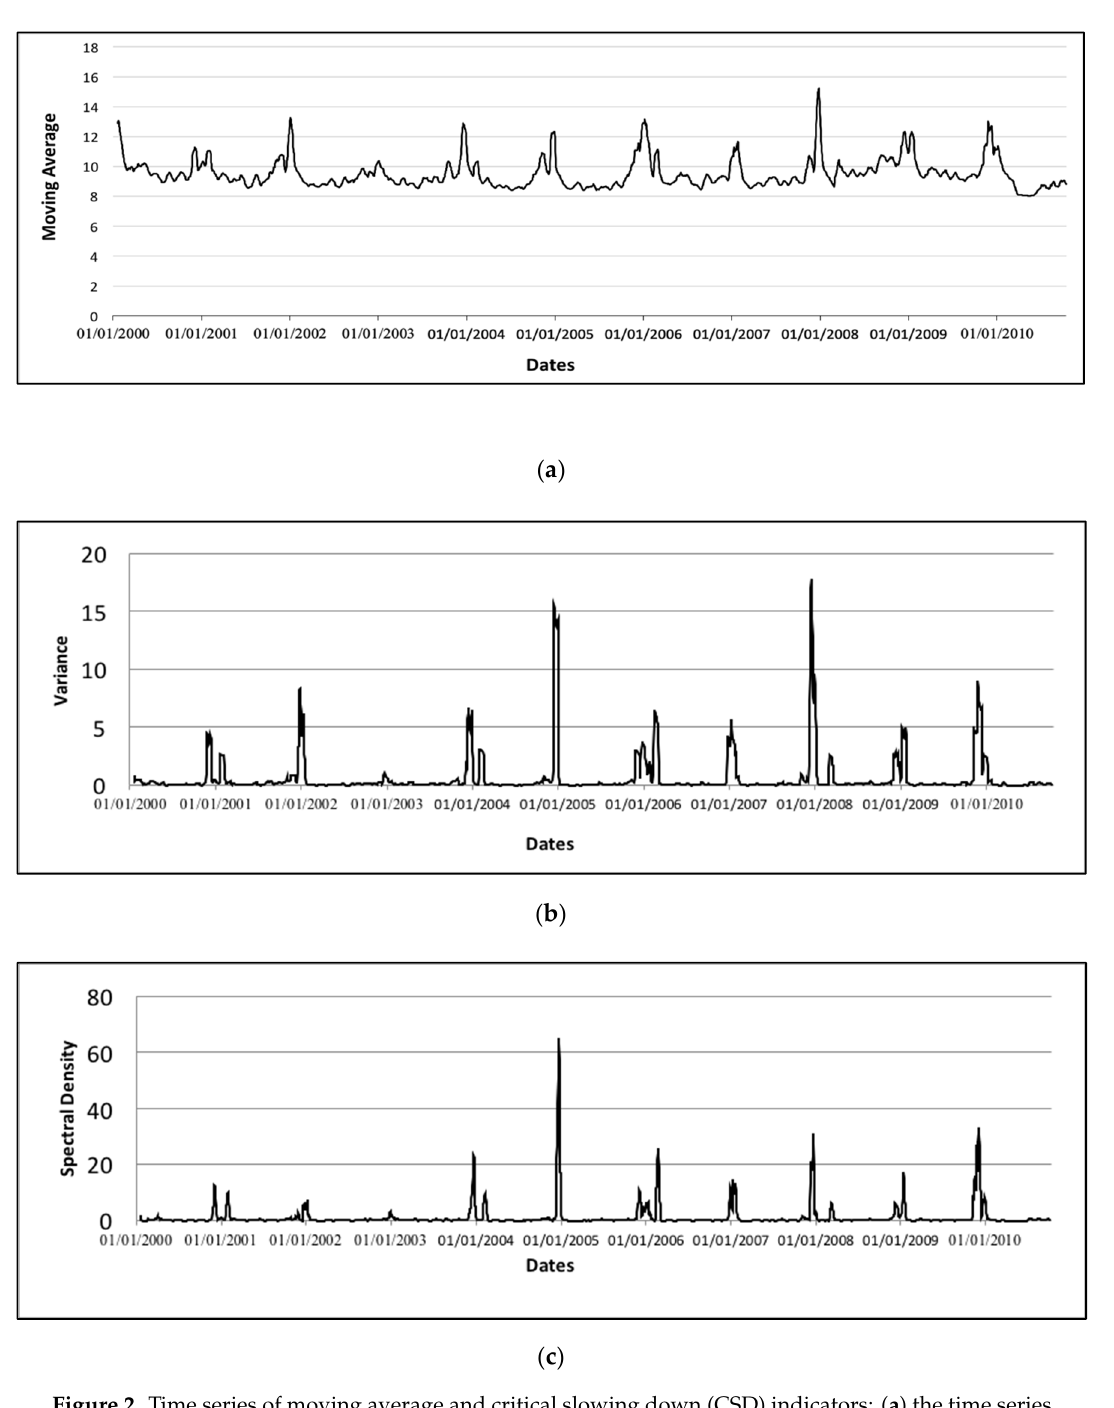
Figure 2. Time series of moving average and critical slowing down (CSD) indicators: ( a ) the time series of twenty days’ moving average of the water level data of Kelantan River; ( b ) the variance of the water level data of Kelantan River; ( c ) the average spectral density at low frequencies of the water level data of Kelantan River.